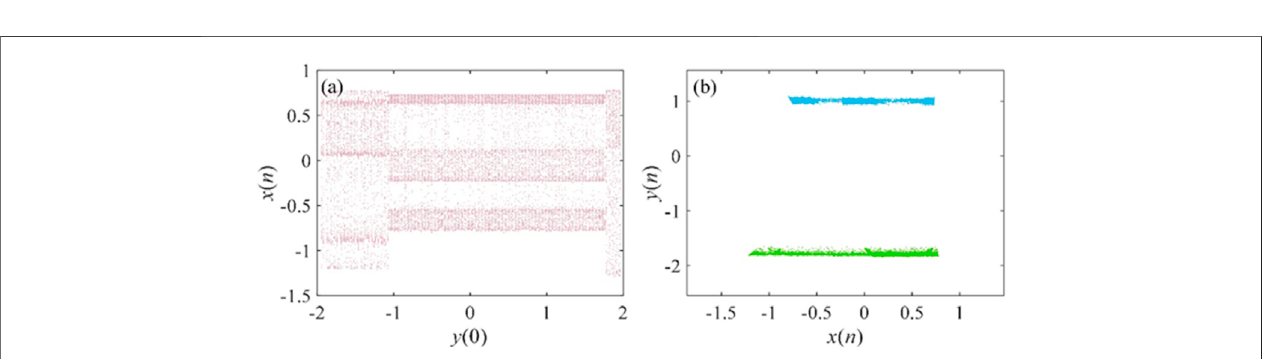
FIGURE 9 | Experimental results graph when a = 0.72. (A) Bifurcation with initial value y (0); (B) Attractors coexistence phase diagram.